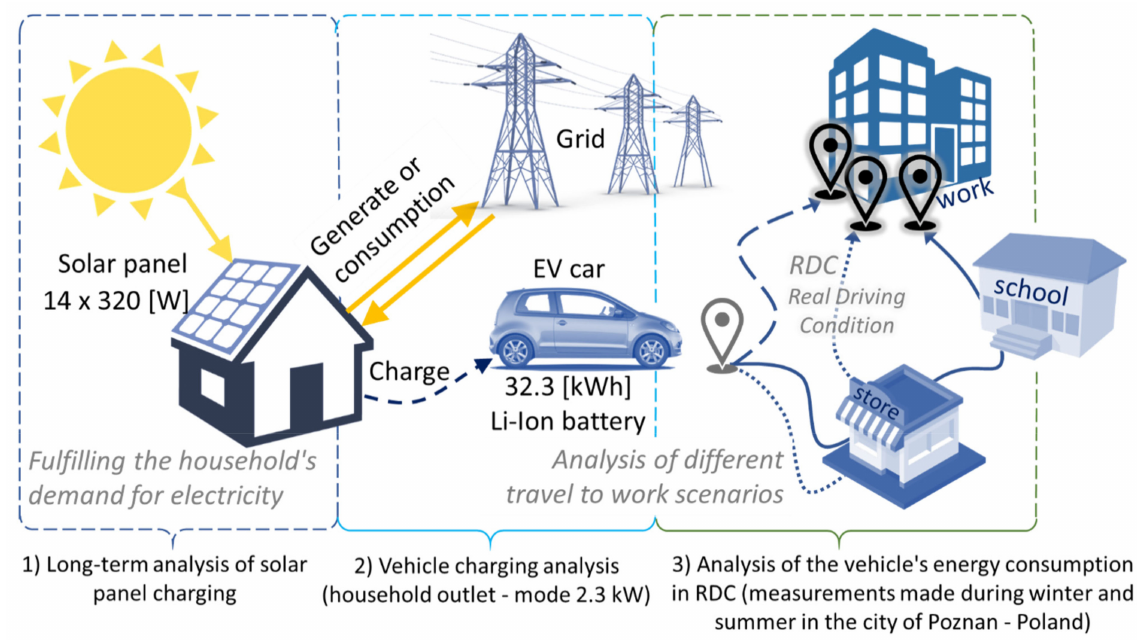
Figure 1. Division of analysis carried out in the discussed